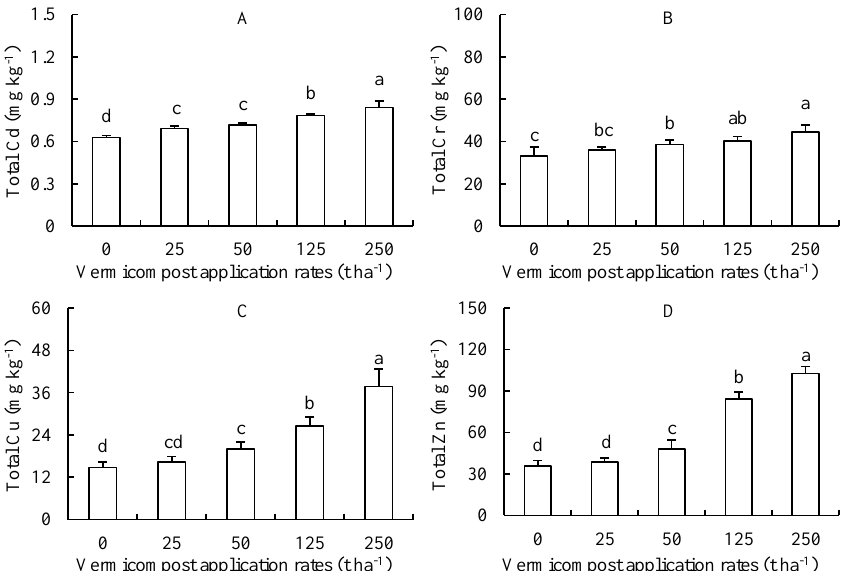
Figure 3. Effects of vermicompost application on total metal concentrations for Cd ( A ), Cr ( B ), Cu ( C ), and Zn ( D ) in mudflat salt-affected soil. Values are the mean of three replicates, and bars show standard deviation. Columns with different letters show a significant difference between sewage sludge amendment rates at p < 0.05 by LSD’s multiple range test. Cd, cadmium; Cr, chromium; Cu, copper; Zn,